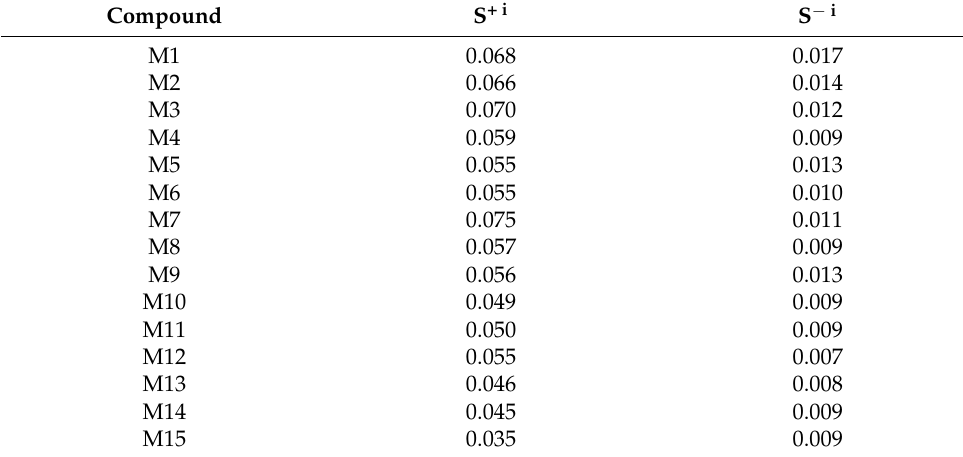
Table 18. COPRAS solutions.